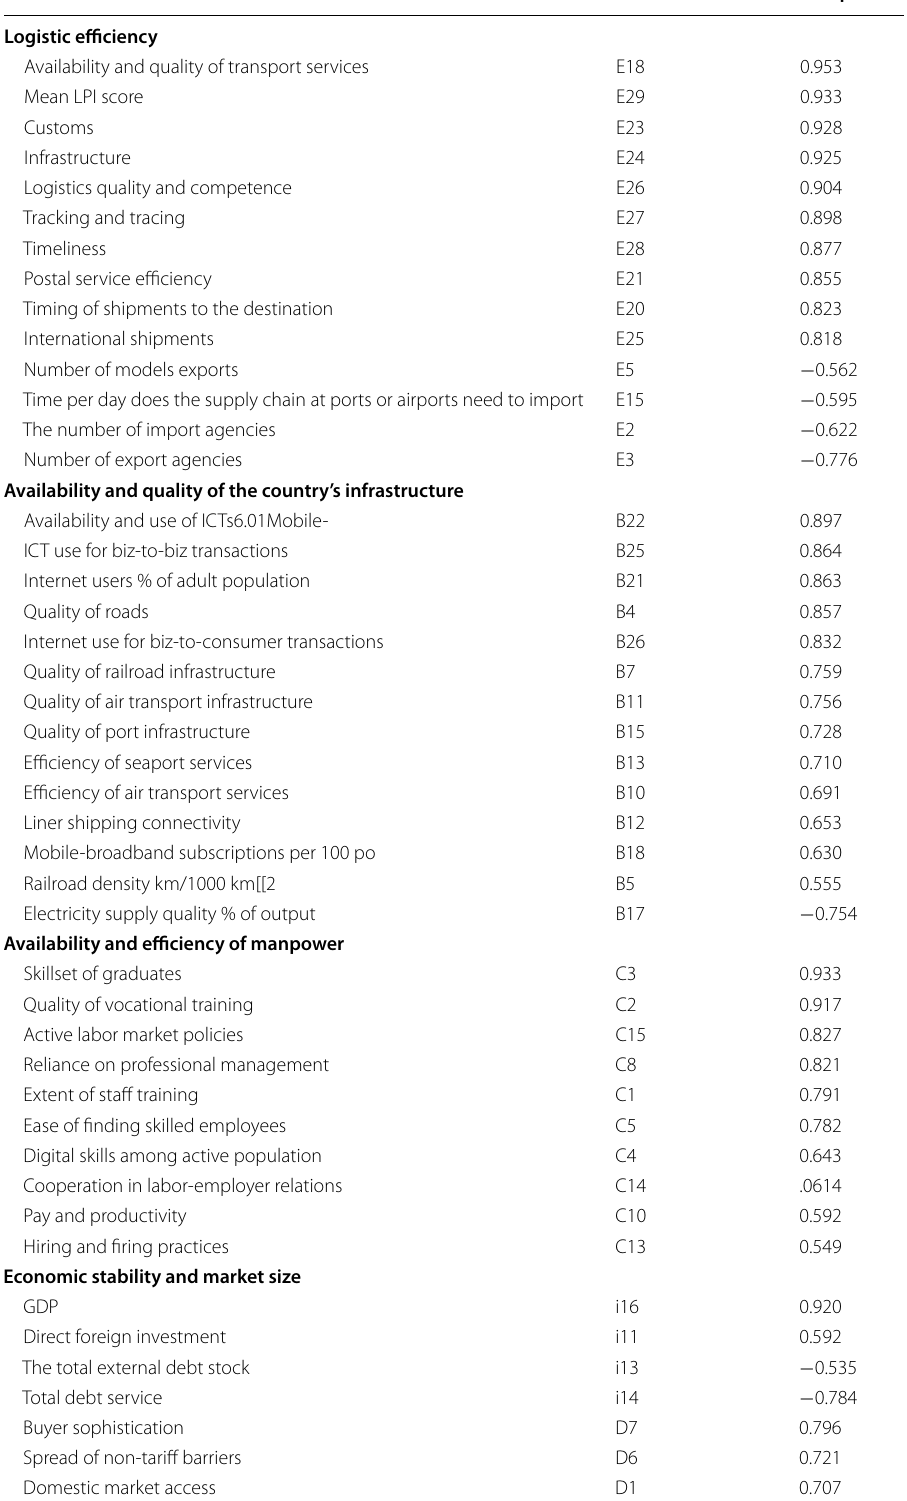
Table 8 Component matrix for national variables Variables